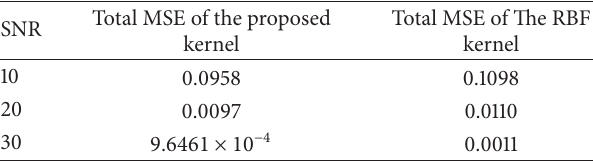
Table 1: Comparison of the total mean square